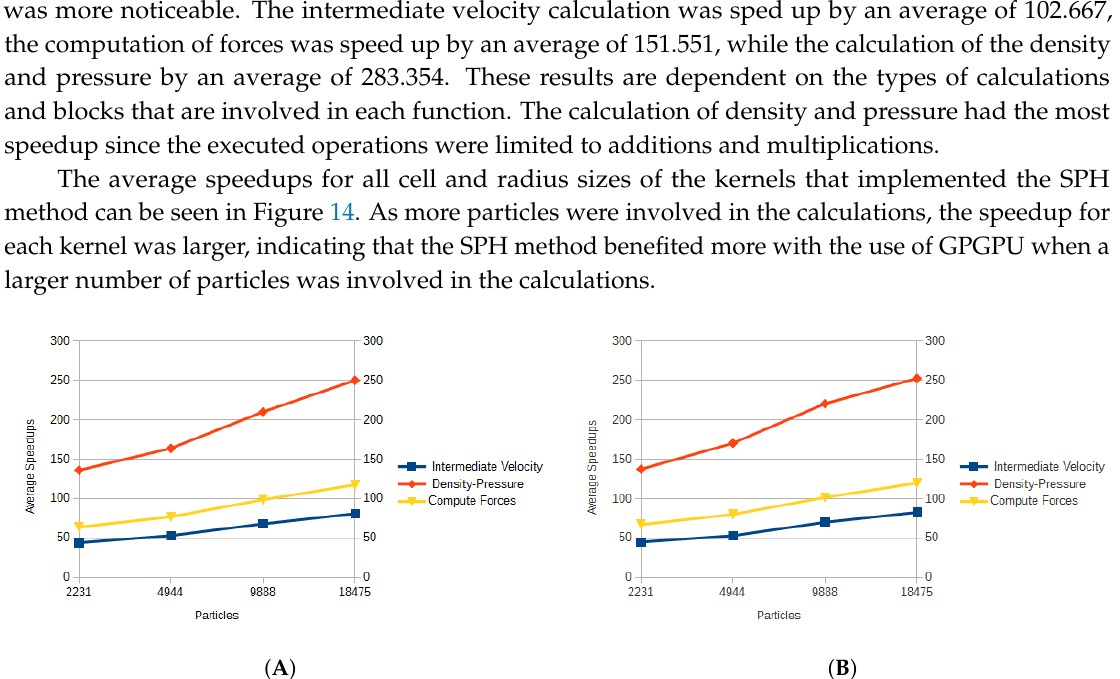
Figure 14. Average speedups obtained for each kernel and each particle set. ( A ) shows the average speedups for the triceps, ( B ) shows the average speedups for the vastus